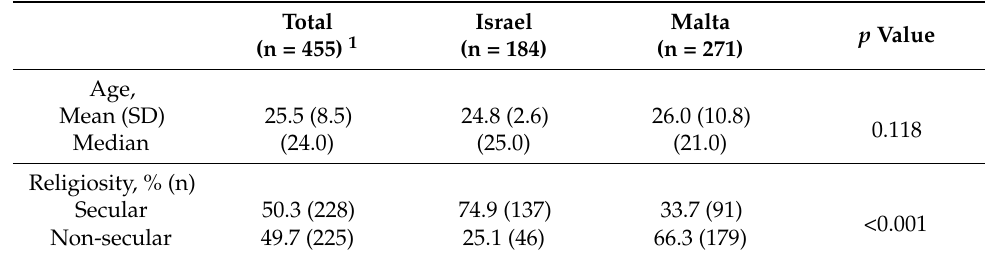
Table 1. Demographic characteristics.